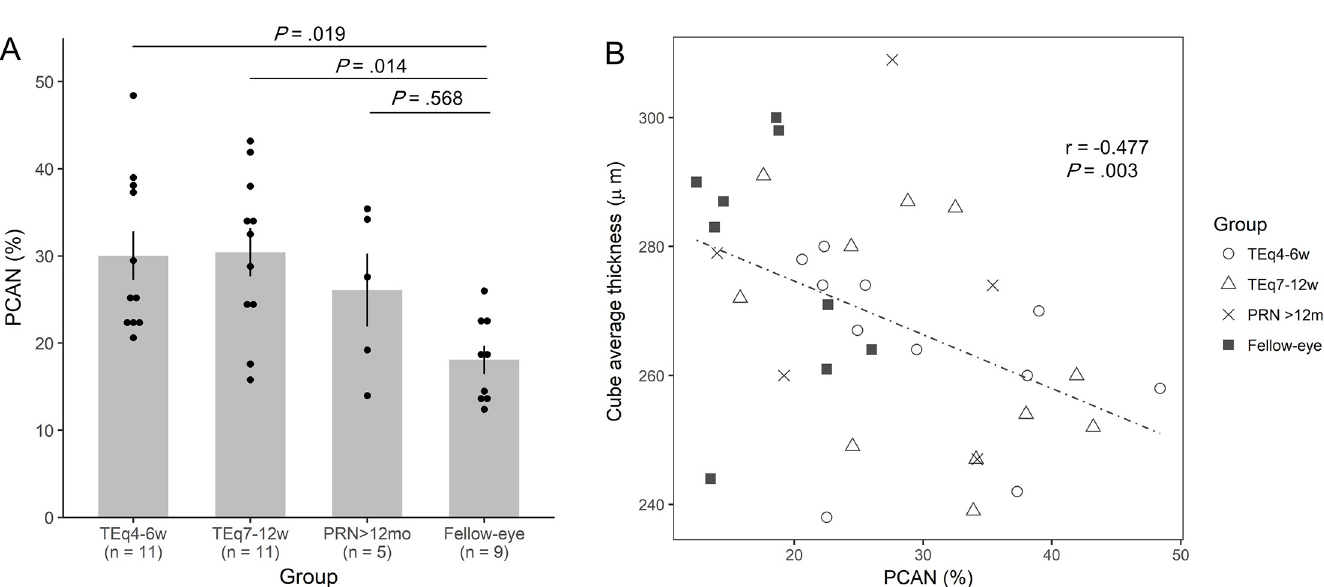
Fig 6. Percentage of choriocapillaris area of nonperfusion (PCAN) in each group and its correlation with cube average thickness. A, A bar plot representing mean PCAN in each group. Error bars represent standard error of the mean and each dot represents one eye. Mean PCAN was significantly higher in TEq4-6w and TE7-12w group compared with the fellow-eye group. B, Scatter plot representing PCAN versus cube average thickness showing a negative correlation between two variables in all study eyes.